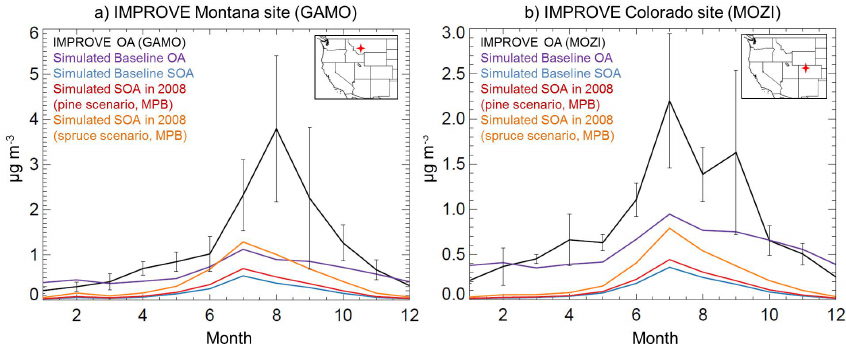
Fig. 10. Comparison between observed baseline IMPROVE OA concentrations from 2008 to simulated baseline OA and SOA at a site in (a) Montana (GAMO) and (b) Colorado (MOZI). Simulated SOA concentrations under the pine and spruce scenario are also shown. Error bars for IMPROVE observations are standard deviation of monthly